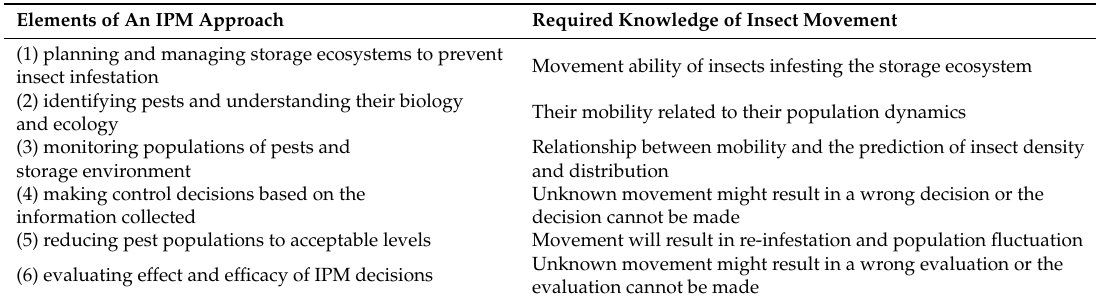
Table 5. Relationship between elements of an integrated pest management (IPM) approach and required knowledge of insect